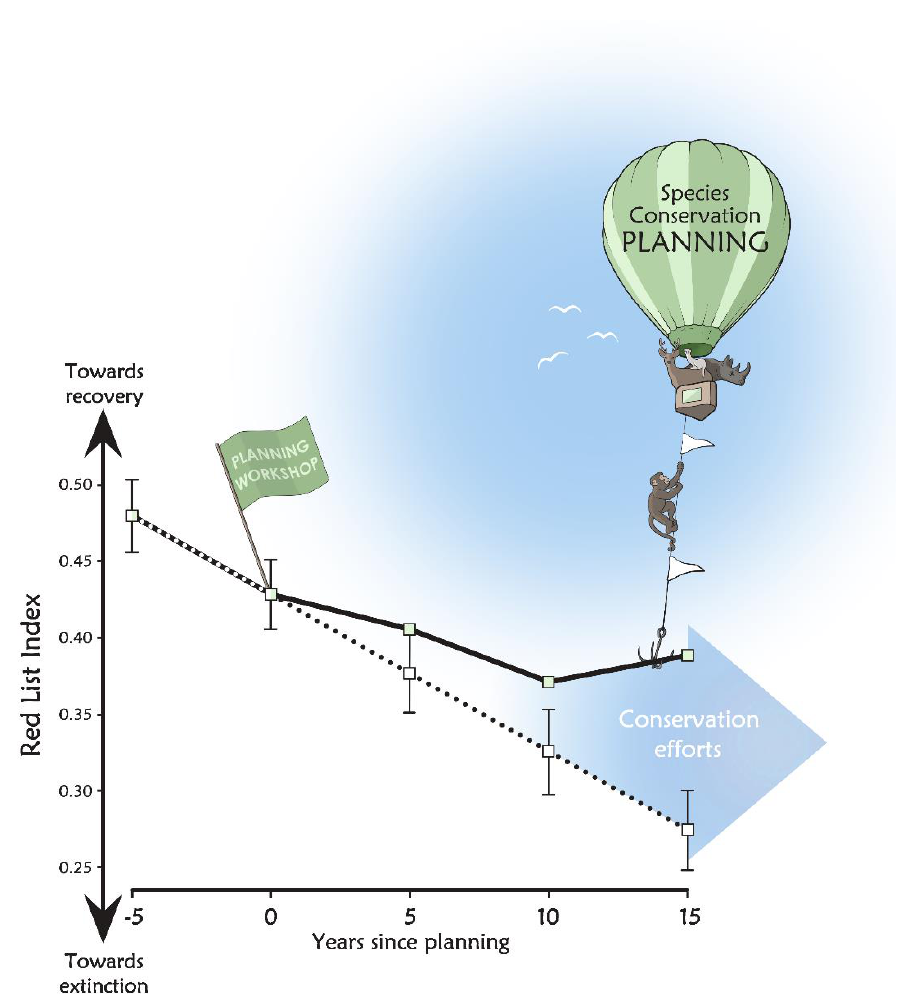
Figure 2. CPSG-style planning helps to reverse the decline of threatened species. The Red List Index (RLI) uses IUCN Red List categories to measure the projected overall extinction risk over time. An RLI value of 1.0 equates to all species being categorized as ‘Least Concern’, and hence that none are expected to go extinct in the near future. A value of 0 indicates that all species have gone extinct. Graphic adapted from Lees et al. 2021 [13].